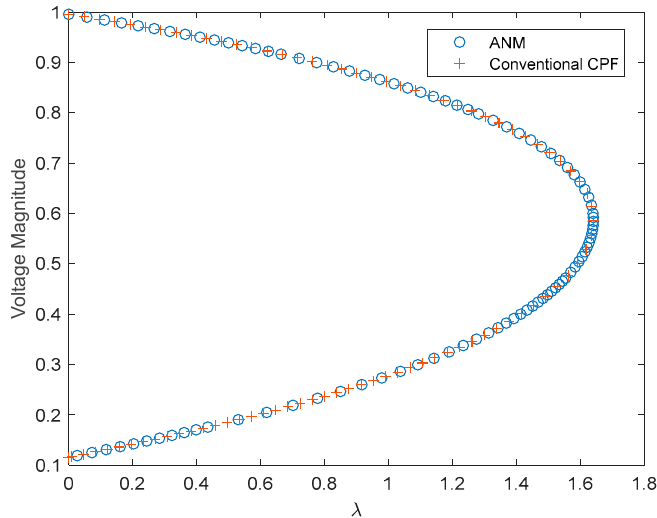
Figure 1. V-lambda curve of bus 9 for both methods.